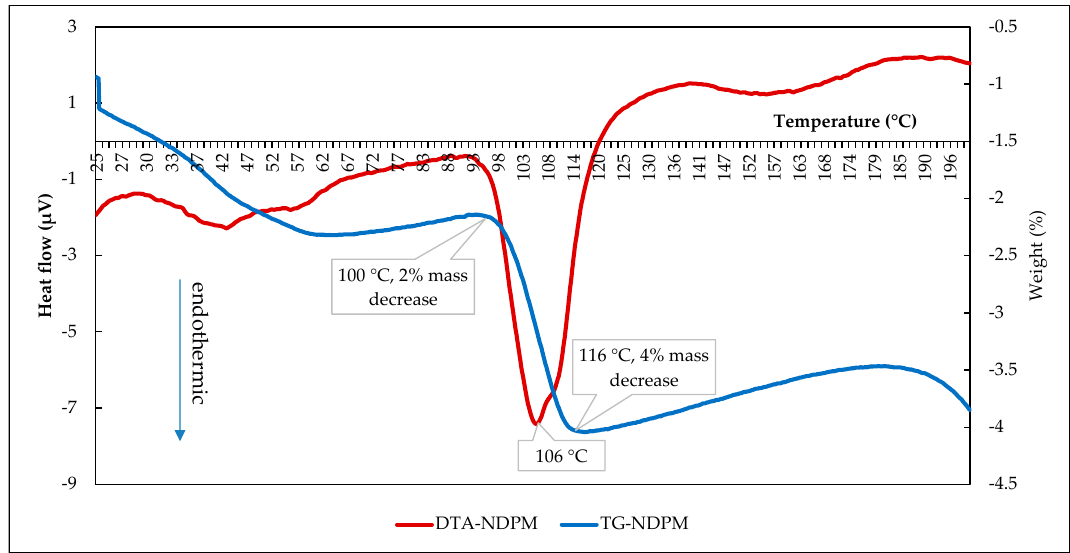
Figure 10. DTA and TG thermograms of NDPM.